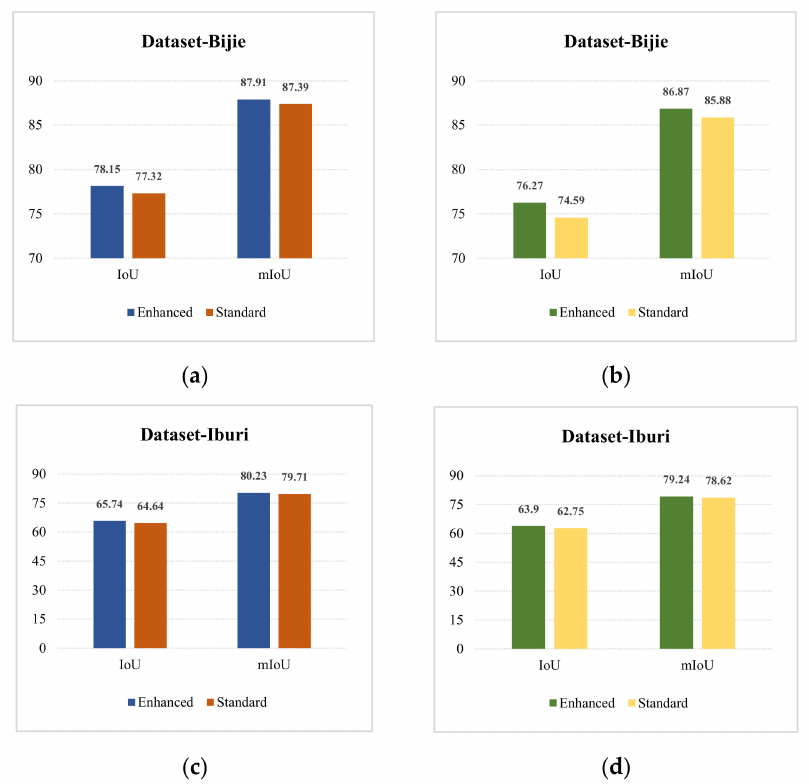
Figure 8. The performance of two models on the Bijie and Iburi datasets before and after data augmentation. ( a , c ) represent the proposed model, ( b , d ) represent